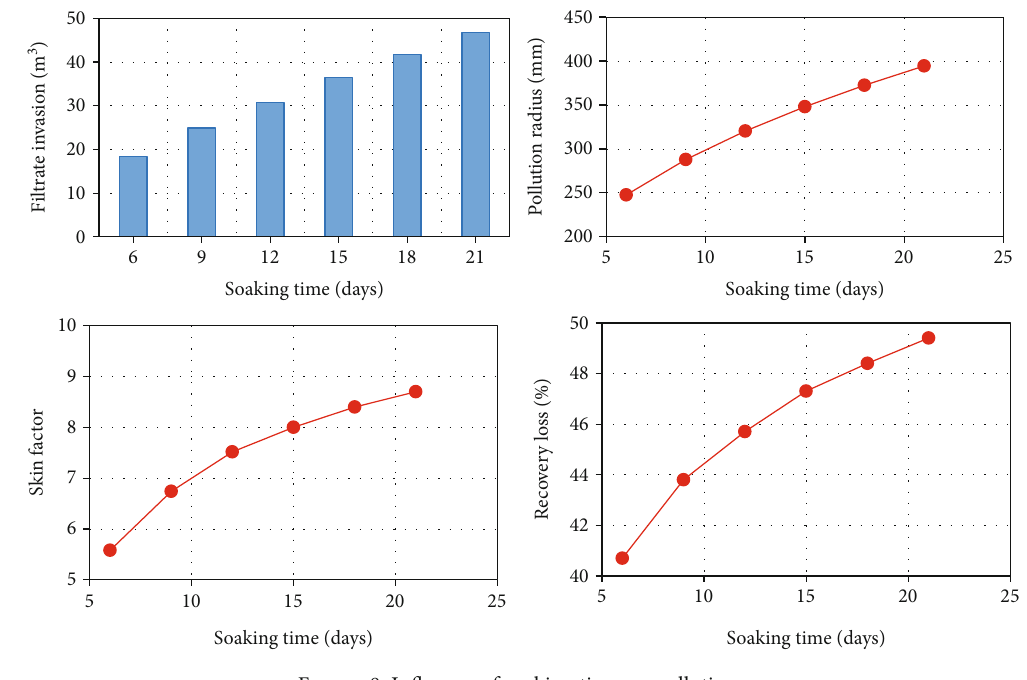
Figure 8: In fl uence of soaking time on pollution.